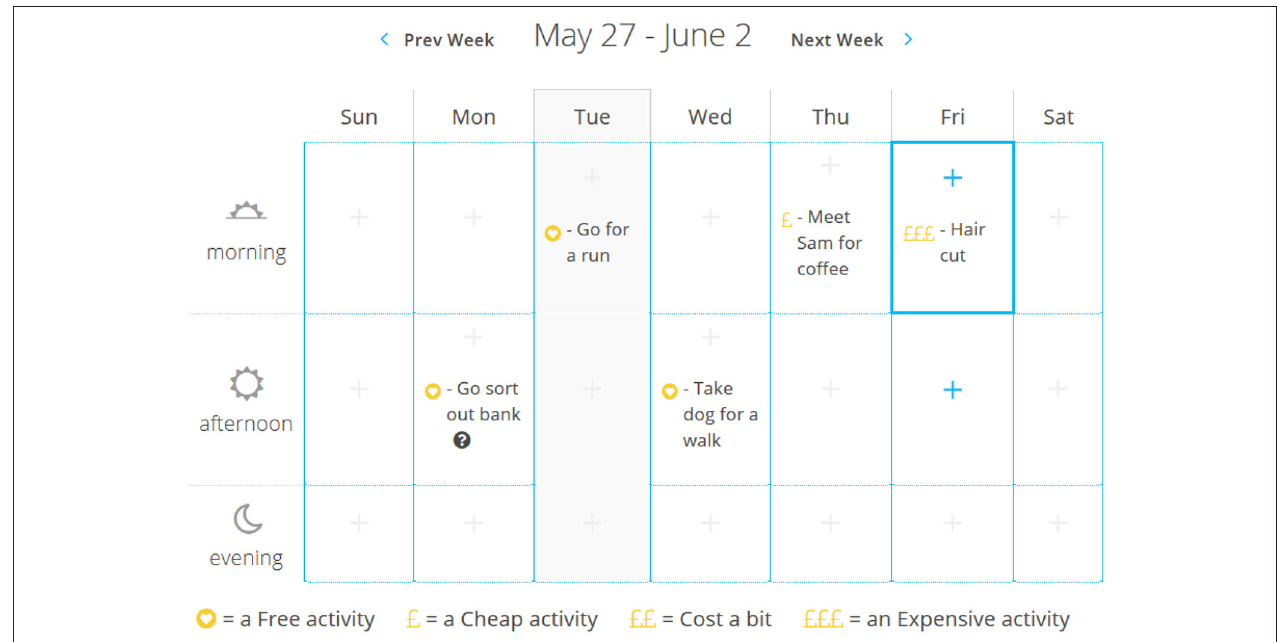
FIGURE 3 | A screenshot from space from money worries: activity scheduling tool with prices included to allow for sticking to a budget.